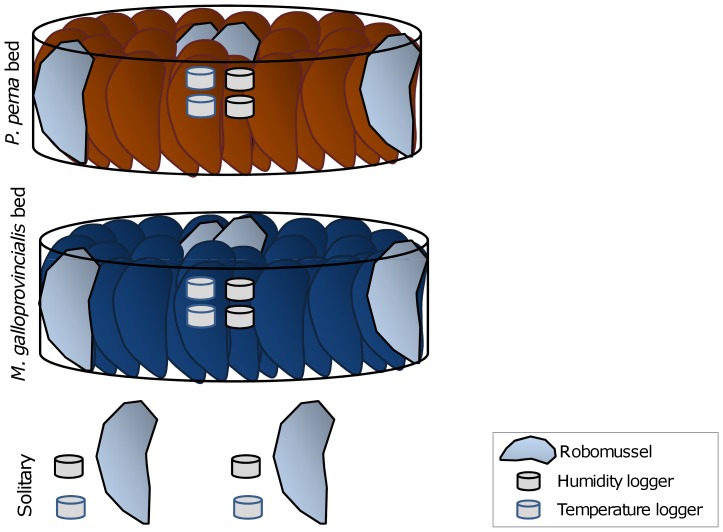
Schematic diagram of the experimental design of the laboratory group experiment.The experiment consisted of three treatments: P. perna bed, M. galloprovincialis bed and solitary individuals. Three replicates of each treatment were set up and the whole experiment was performed twice.